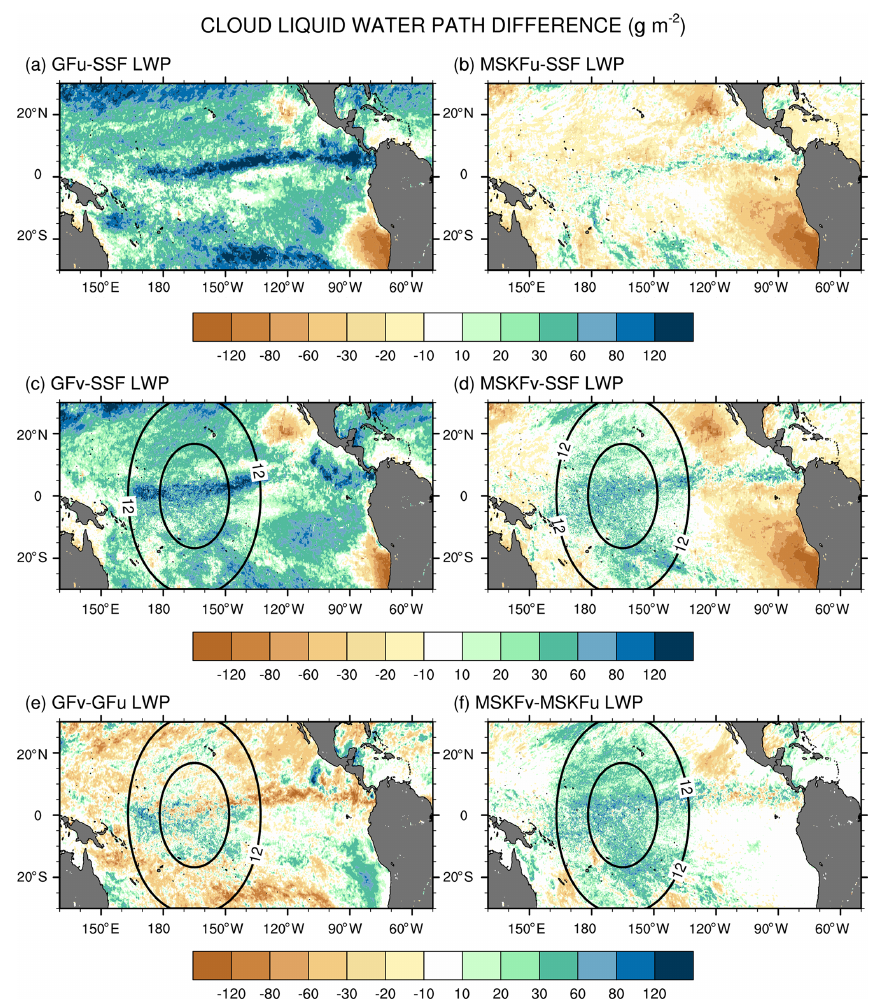
Figure 13. Monthly-mean cloud liquid water path (LWP) difference over the tropical Pacific Ocean between (a, b) GFu (MSKFu) and SSF data and (c, d) GFv (MSKFv) and SSF data and monthly-mean LWP difference between (e, f) GFv (MSKFv) and GFu (MSKFu) for December